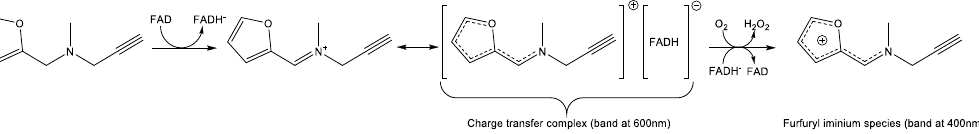
Figure 11. F2MPA partly reduces MAO-A but also forms a charge-transfer complex. Difference spectra were calculated by subtracting the spectrum of anaerobic MAO-A alone from that after incubation with 4. ( a ) Anaerobic F2MPA (2 mM) was added to anaerobic MAO-A (13.4 μ M) and spectra collected every 10 min for 2.5 h (spectra at 10 min and 2.5 h shown) and then every hour. ( b ) Time course for reduction of MAO-A (495 nm for bleaching of the FAD; 456 nm is isosbestic), adduct formation (400 nm) and formation of a charge transfer species (595